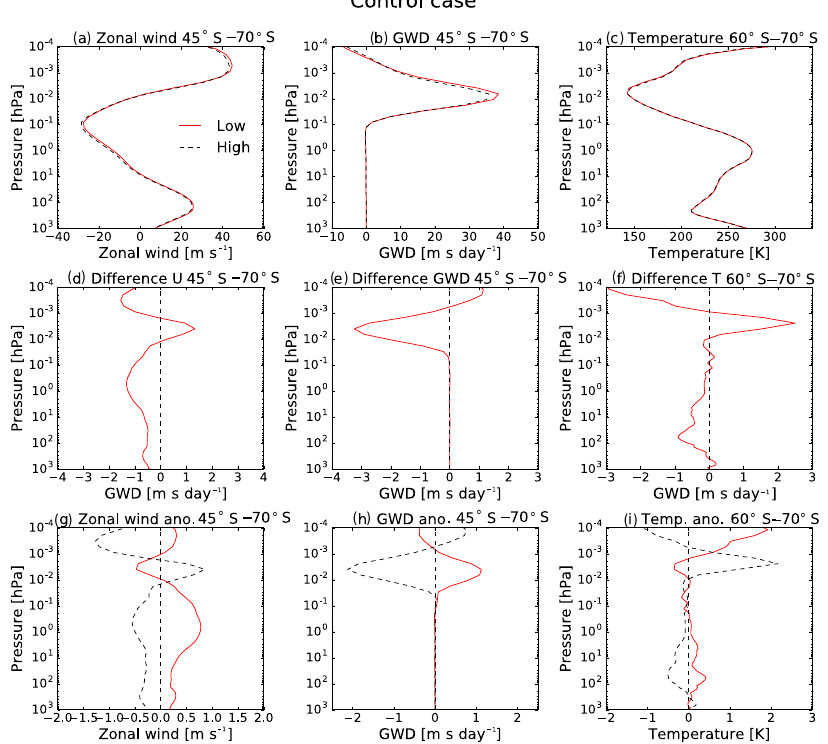
Figure 7. The January zonal wind (a, d, g) and the GW drag (b, e, h) between 45–70 ◦ S and the temperature (c, f, i) between 60–70 ◦ S for anomalously low and high temperatures in the winter stratosphere (1–10hPa, 50–60 ◦ N) (a–c) and the differences between them (d–f) and their anomalies (g–i) , for the case where there are GWs in the winter hemisphere. The red continuous lines show the results for anomalously low temperatures and the black dashed lines show the results for the anomalously high